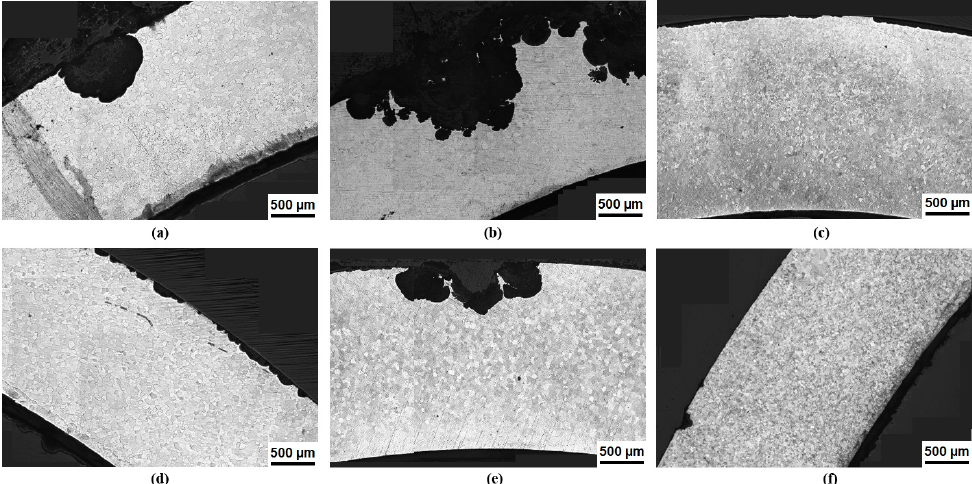
Figure 5. Optical micrographs of corroded C-rings after plastic deformation over 7 days for ( a , d ), Mg10Dy ( b , e ) and Mg1Nd alloys ( c , f Mg10Dy1Nd ( a , d ), Mg10Dy ( b , e ) and Mg1Nd alloys ( c , f ).